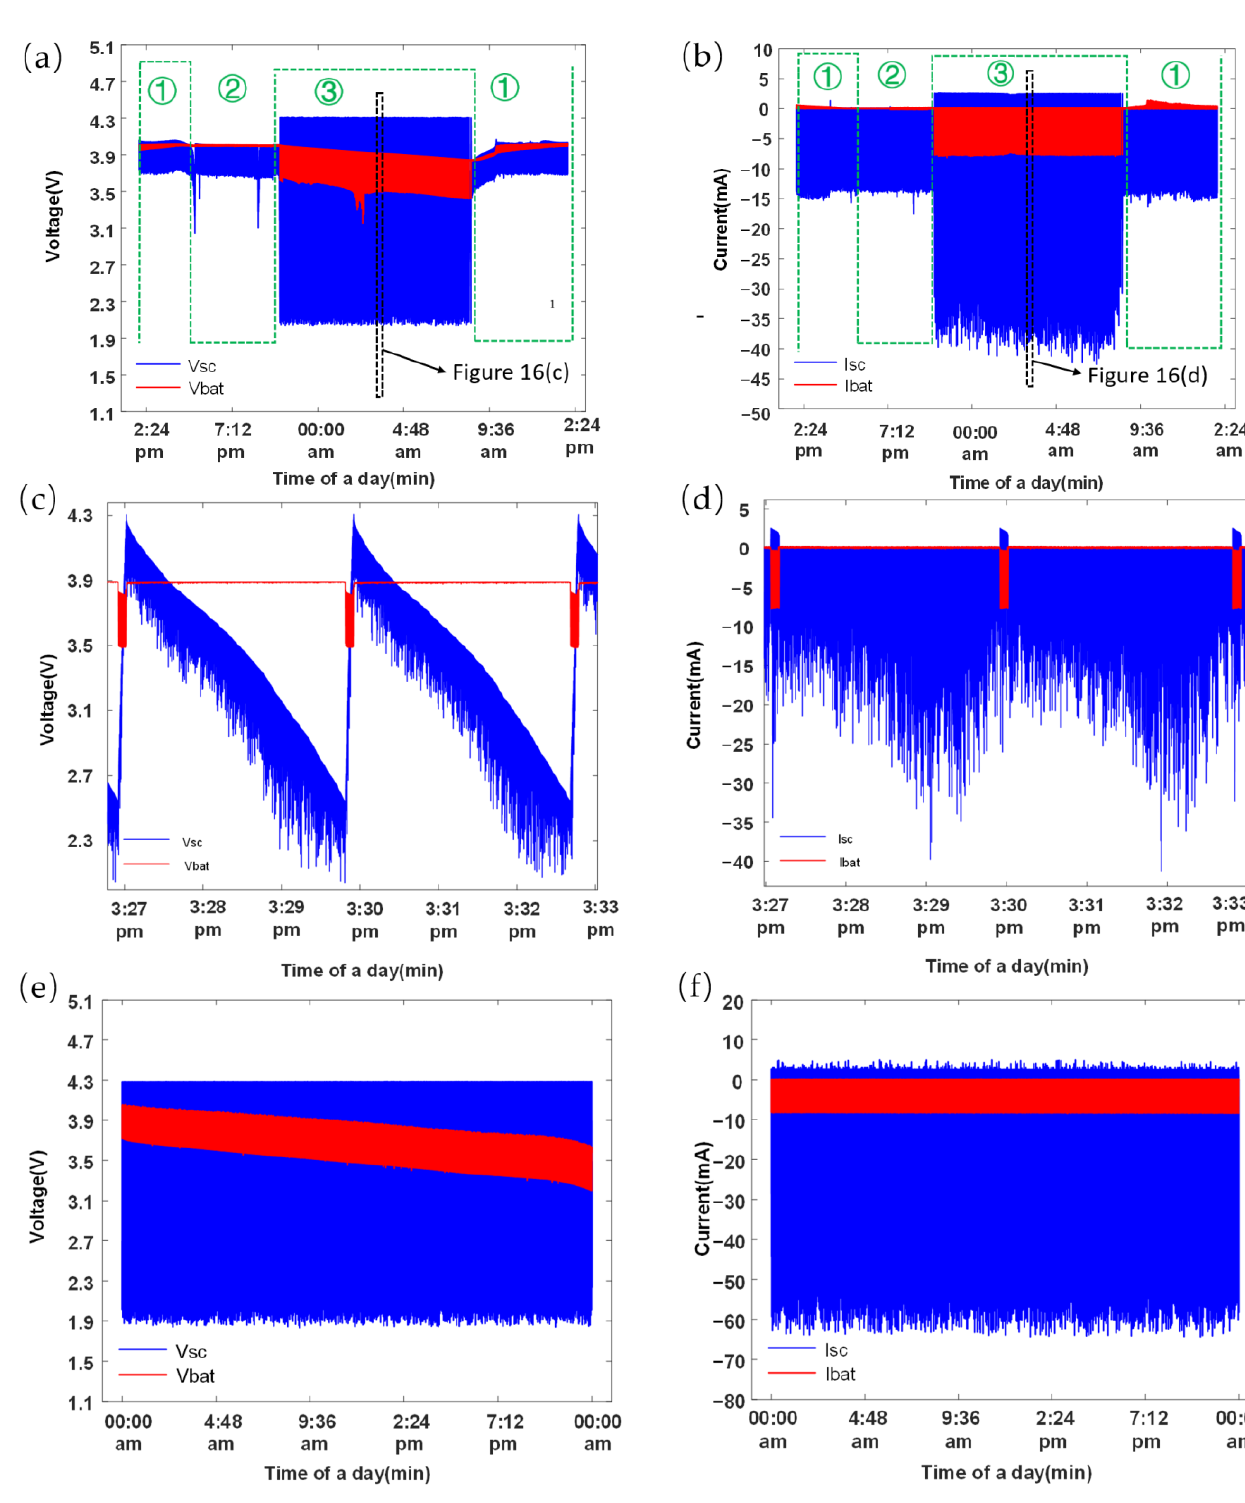
Figure 16. Daily performance of self-powered IoT sensor nodes. ( a ) The voltages of battery and SC; ( b ) The currents of battery and SC; ( c ) Local enlargement of ( a ); ( d ) Partial enlargement of ( b ); ( e ) The voltages of battery and SC under extreme conditions; ( f ) The currents of battery and SC under extreme conditions. The serial numbers in the sub-figure (a, b) indicate different time periods, with 1 representing 7:30 a.m. to 5:00 p.m., 2 representing 5:00 p.m. to 9:00 p.m., and 3 representing 9:00 p.m. to 7:30 a.m., covering a total of 24 h.